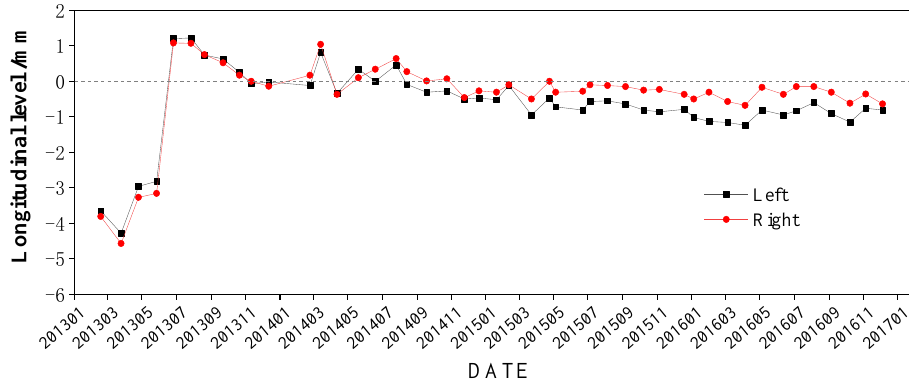
Figure 27. Variation curve of track longitudinal level with time at 177.034 km of a HSR line. Through field investigation, from June 9 to 24, 2019, the engineering department carried out large machine tamping operation for the downward line. The effect of operation is obvious. In Figure 28a, b, the amplitude of track longitudinal level is reduced from − 2.13 mm to − 0.20 mm, as shown in Figure 28c. The TQI from 174.000 km to 174.200 km section is reduced from 4.81 to 3.06, and track state is significantly improved, as shown in Figure 28d.